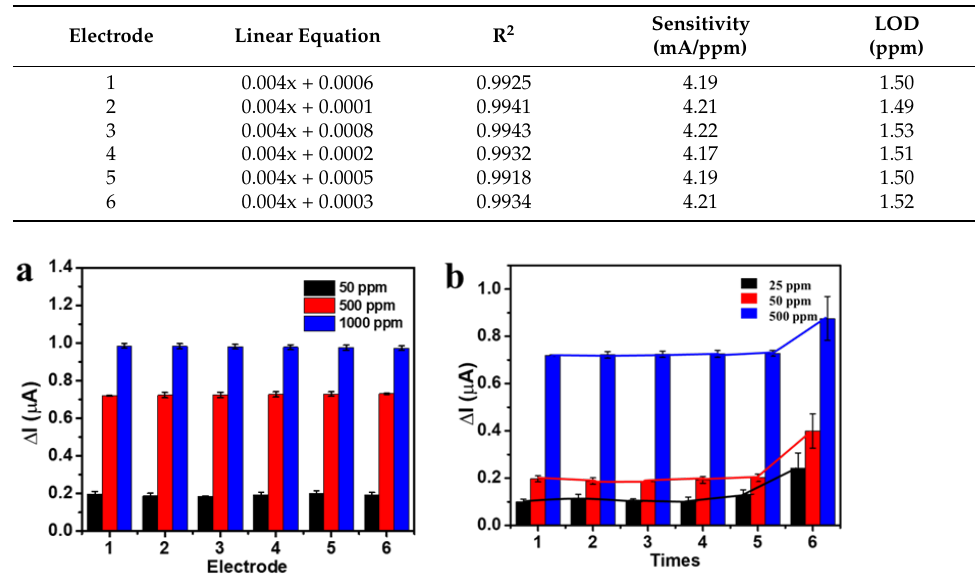
Table 2. Stability of MMIP – gluten electrode fabrication.